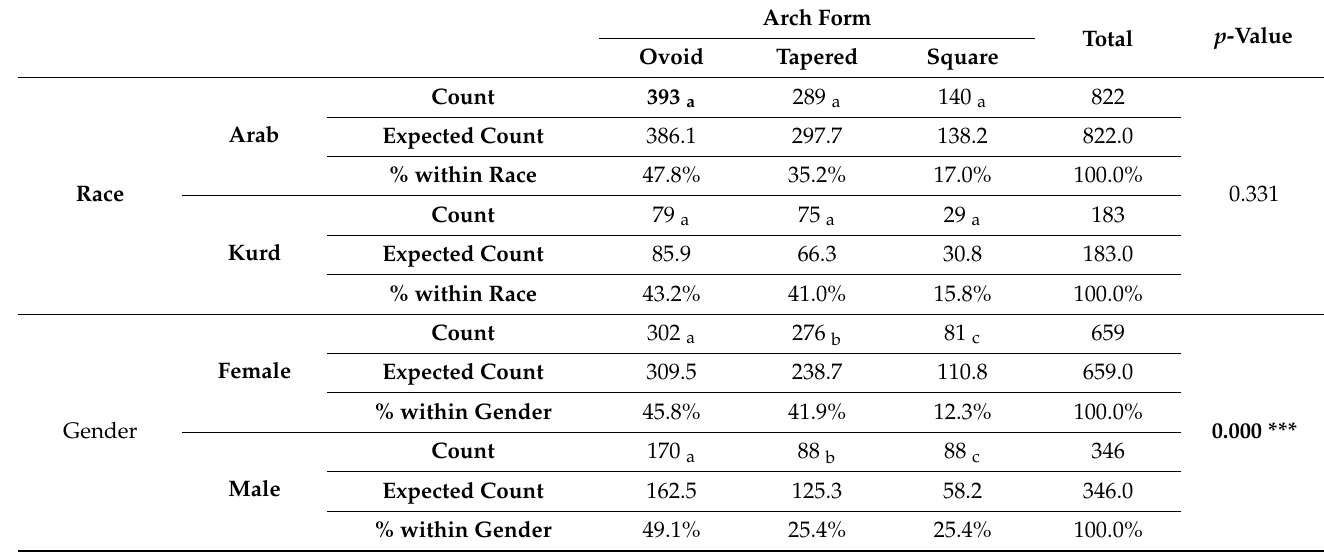
Table 2. Descriptive statistics and comparison of arch form distribution (chi-square